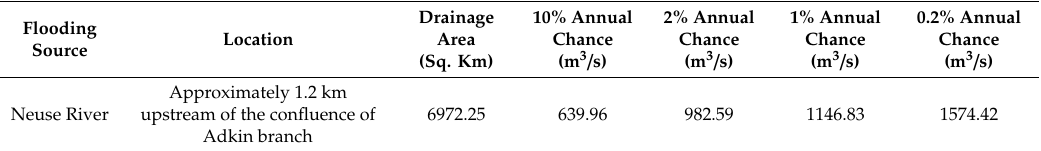
Table 2. Summary of discharge (m 3 / s) at USGS gage site 02089500, downstream of study reach given by FFR